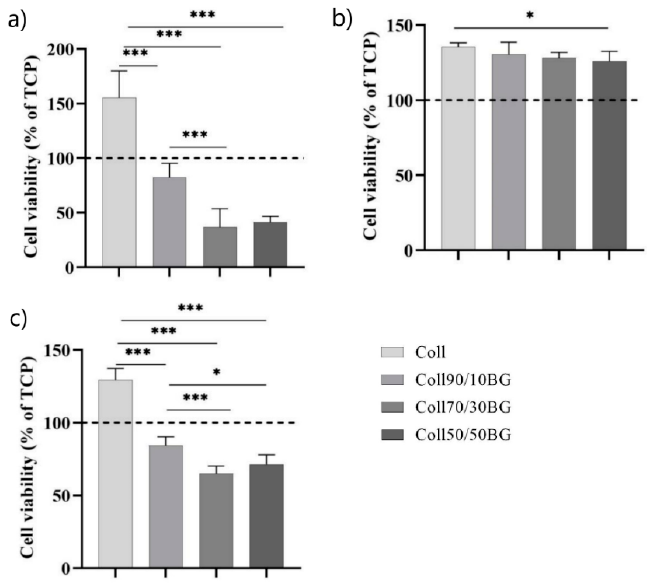
Figure 5. Viability of HaCaT cells ( a ) after 24 h direct culture on the materials, ( b ) after 24 h exposure to the material extracts, and ( c ) after 72 h direct culture on the materials that were “pre-conditioned” for 24 h with culture medium. * p ≤ 0.05; *** p ≤ 0.001.